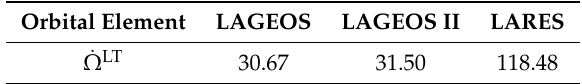
Table 5. Rate (mas/yr) for the secular Lense-Thirring precession on the RAAN of the two LAGEOS and LARES